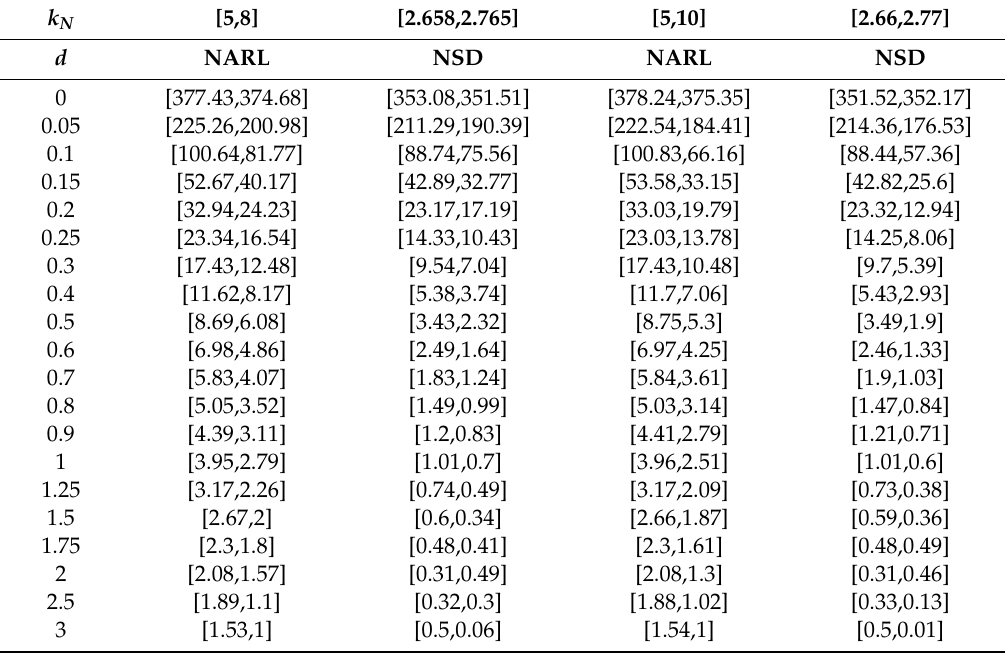
Table 4. The values NARL and NSD when n N (cid:15) [ 5,10 ] , n N (cid:15) [ 5,8 ] ,and λ N (cid:15) [ 0.08,0.12 ]